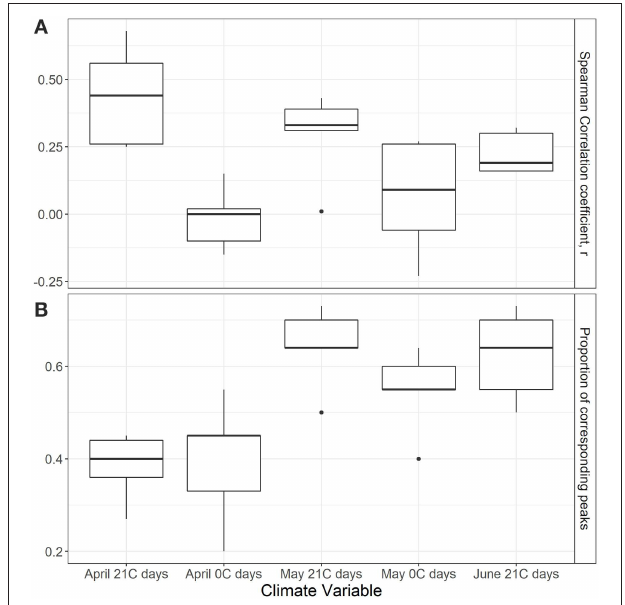
FIGURE 5 | Boxplots showing distribution of (A) Spearman correlation coefficients and (B) proportion of corresponding peaks between breeding population indices for the five migrant butterflies ( Table 1 ) and weather indices, where April/May 21 days and April/May 0 days are the mean number of 21 ◦ C days (or greater) and 0 ◦ C days (or less), respectively, during the month of April in the lower U.S., and the month of May in the mid